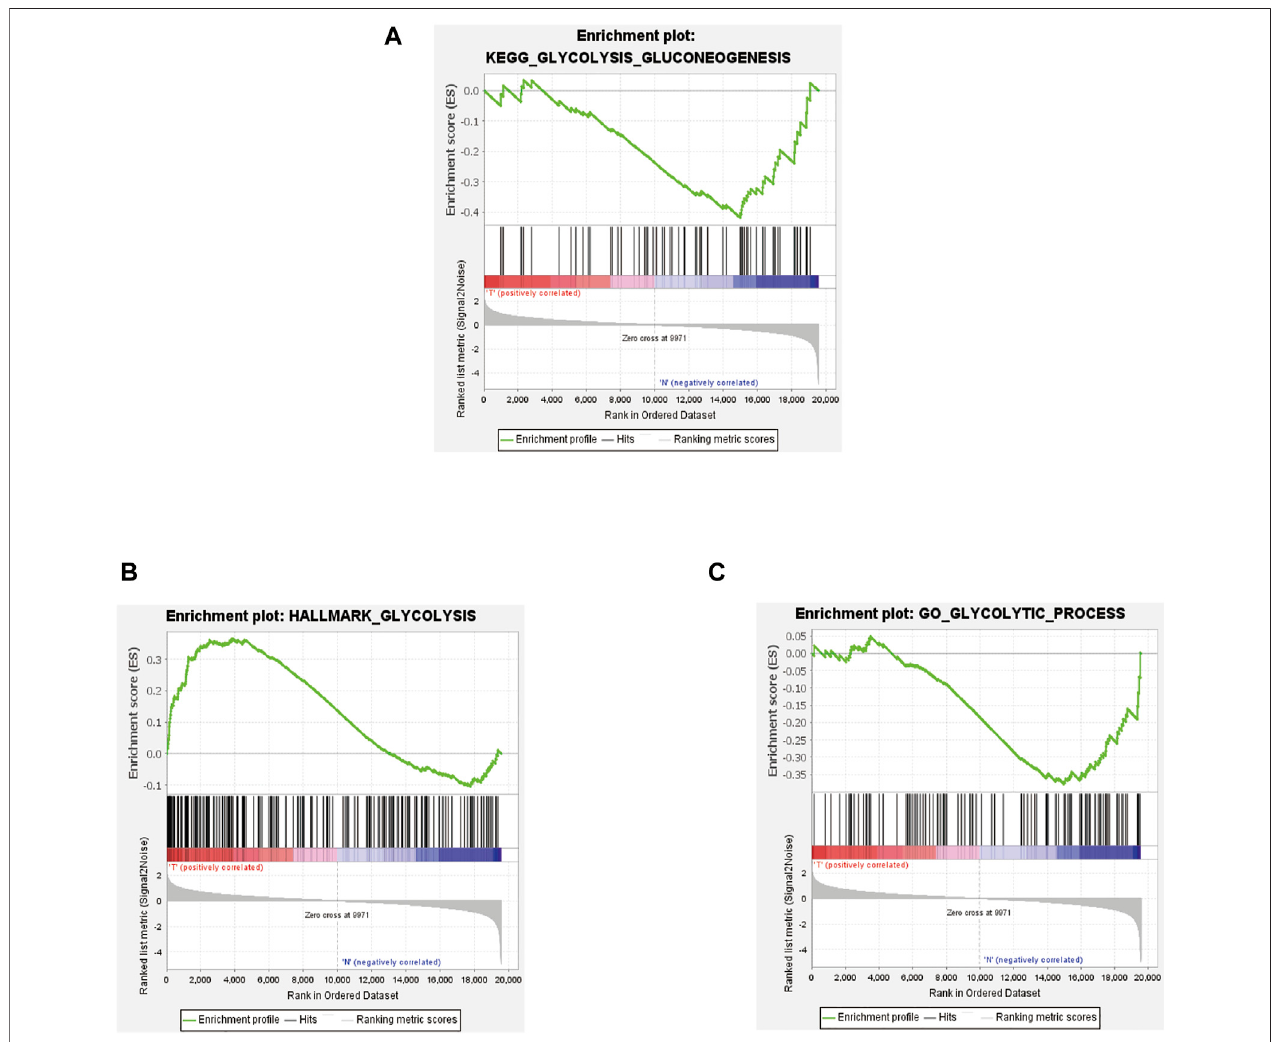
FIGURE 2 | Results of GSEA based on glycolysis-related gene sets. KEGG_GLYCOLYSIS_GLUCONEOGENESIS (A) , HALLMARK_GLYCOLYSIS (B) , GO_GLYCOLYTIC_PROCESS (C) .